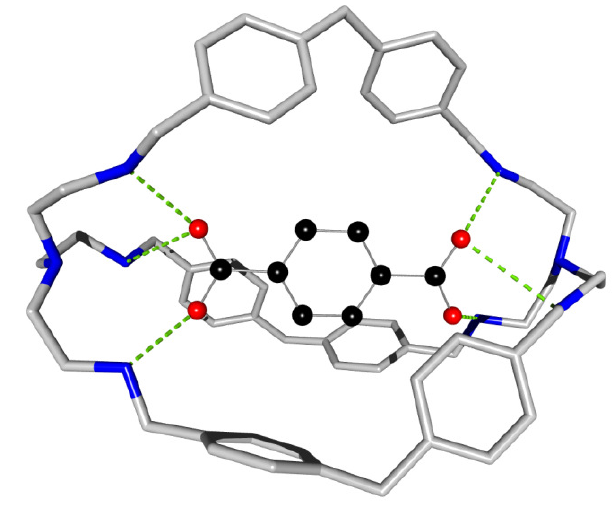
Figure 4. Binding of the terephtalate anion to the tris (biphenyl) crytand through secondary ammonium hydrogen bonds and additional arene